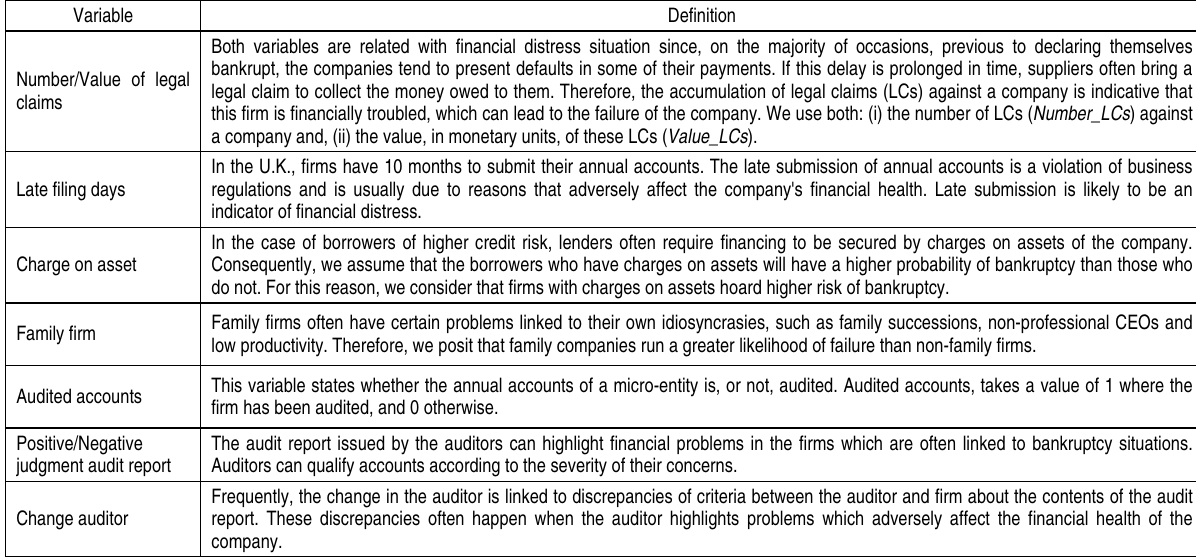
Table A.3. Definition and explanation of the non-financial predictor